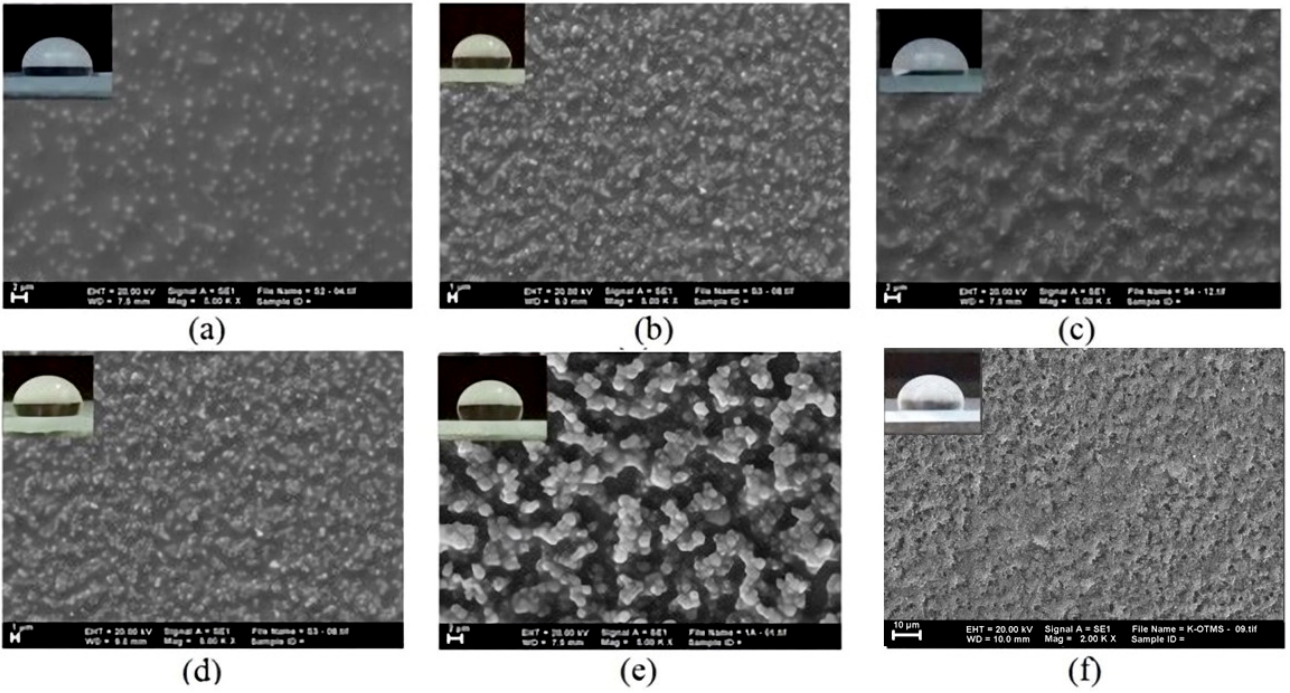
Figure 3. The SEM images of SiO 2 -TiO 2 -OTMS coatings prepared with ( a ) 7.5, ( b ) 15, and ( c ) 30 mmol of SiO 2 (x mmol SiO 2 , 7.5 mmol TiO 2 , and 15 mmol OTMS), ( d ) 7.5, ( e ) 15, and ( f ) 30 mmol of TiO 2 (15 mmol SiO 2 , x mmol TiO 2 , 15 mmol OTMS), respectively. The decrease in water contact angle in over 15 mmol of SiO 2 and TiO 2 was also attributed to the increase in the amounts of the hydroxyl groups on the surfaces. The presence of hydroxyl groups enhanced the hydrophilicity of the substrates. We calculated the ratio of peak areas of O-H (~3400 cm − 1 ) and C-H (~3400 cm − 1 ) vibration in 15 and 30 mmol of SiO 2 and TiO 2 , based on the FTIR data, to quantify the hydroxyl groups on the surface (Figure 4). It was found that 15 mmol of SiO 2 and TiO 2 had higher A values than 15 mmol of SiO 2 and TiO 2 . It means that 15 mmol of SiO 2 and TiO 2 had higher hydroxyl groups than 15 mmol of SiO 2 and TiO 2 . The abundance of hydroxyl groups